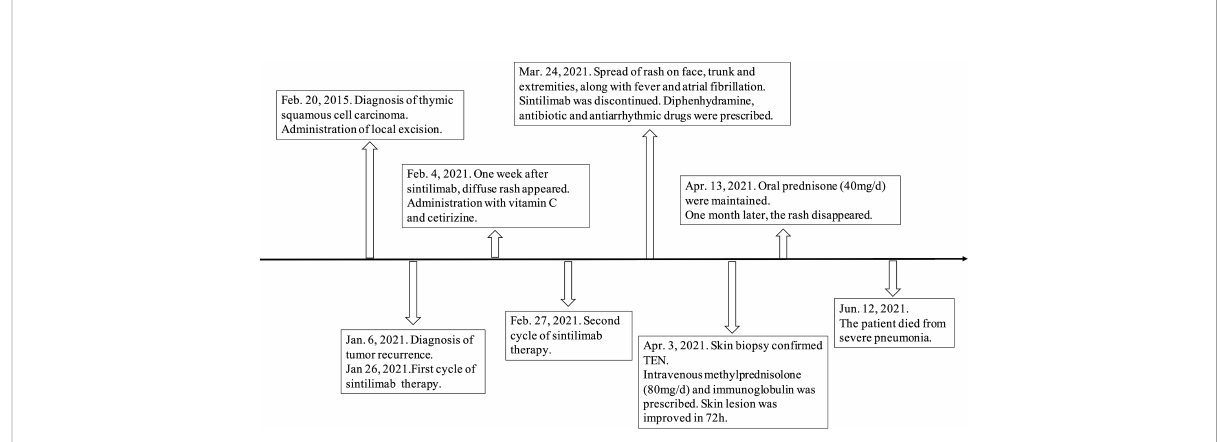
FIGURE 3 Timeline of diagnosis and major interventions. Body weight of this patient was 55